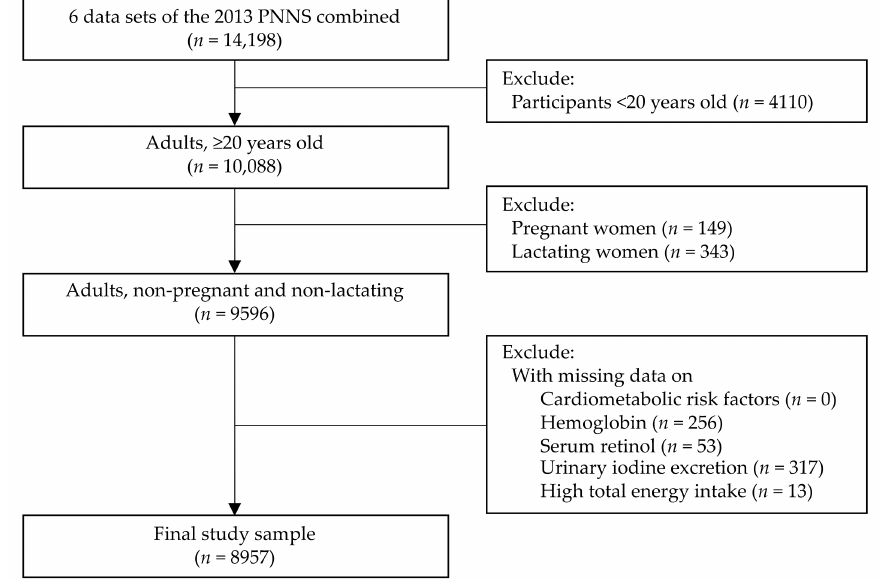
Figure 1. Selection of study participants. (Cardiometabolic risk factors were defined as an individual with any of the following factors: (1) overweight/obesity or abdominal obesity, (2) hypertension, (3) hyperglycemia, or (4) dyslipidemia [low high-density lipoprotein (HDL) cholesterol or hyper- triacylglycerolemia]. There were no study participants with missing values on cardiometabolic risk